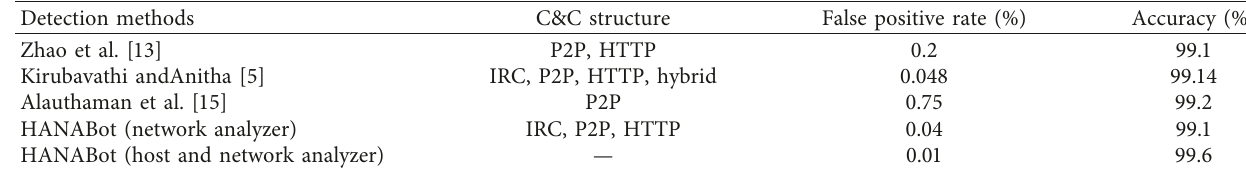
Table 11: Performance comparison with published